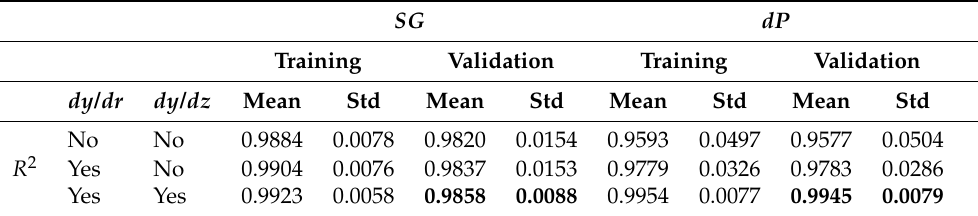
Table A1. Comparison of the R 2 scores of the gas saturation and pressure buildup models depending on the inclusion of derivative errors in the loss function. Errors were averaged across 500 random samples from the corresponding dataset. Three versions were trained for each of the SG and dP models: a model trained without both the r -error and the z -error (i.e., just the normal y error), a model trained with the r -error, but without the z -error, and a model trained with both errors. All of these models were trained for just 100 epochs, leading to larger MPE and MRE values as compared to those in Table 2, where the models were trained for 200 or 250 epochs. Bolded values emphasize the best R 2 scores on the validation data among these